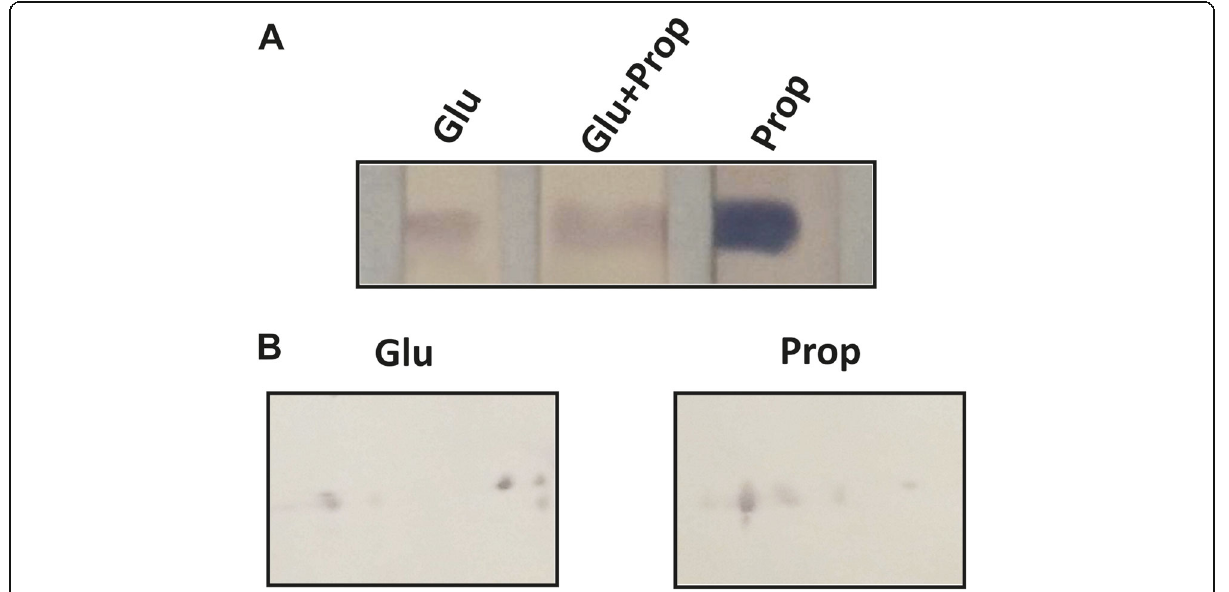
Fig. 5 MCS levels and profiles in fungal cells grown in glucose or propionate. The protein extracts from yeast cells grown on propionate (Prop) and/or glucose (Glu) were subjected to 1-dimensional ( a ) or 2-dimensional ( b ) Western Blot analysis by using polyclonal antibodies raised against rPbMCS. Secondary anti-mouse antibodies coupled to alkaline phosphatase were used and the reaction was developed with BCIP and NBT